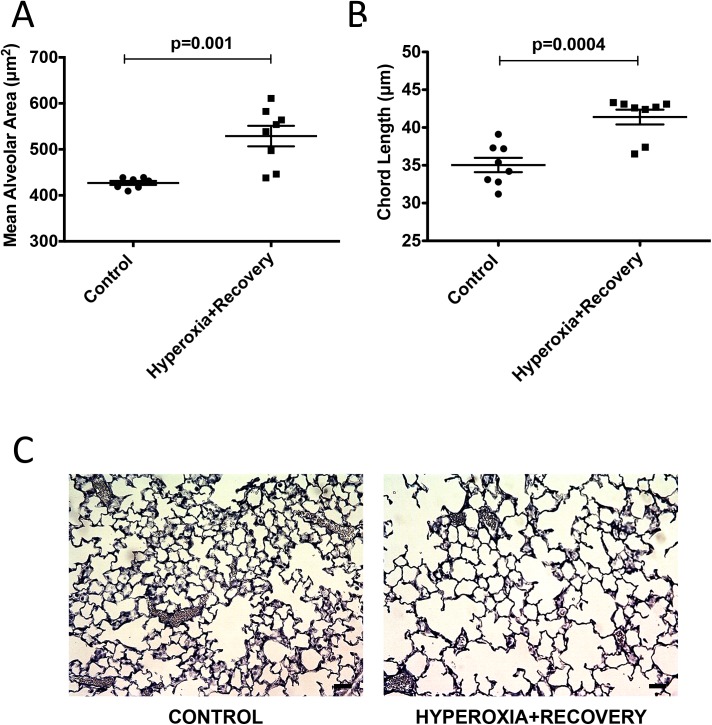
Hyperoxia exposure of neonatal mice is associated with persistent alveolar simplification.Mice were exposed to hyperoxia or room air for 14d, followed by recovery in room air for an additional 7d (21d). (A) Mean alveolar area and (n = 7 animals per group). (B) chord length were measured using Scion software (n = 8 animals per group). (C) Representative hematoxylin-stained lung sections are shown for control 21d and hyperoxia + recovery 21d. Bar = 50 μm. Data are expressed as dot plots with each dot representing individual animals with means and SEM represented by horizontal lines. Results were analyzed using an unpaired t-test.